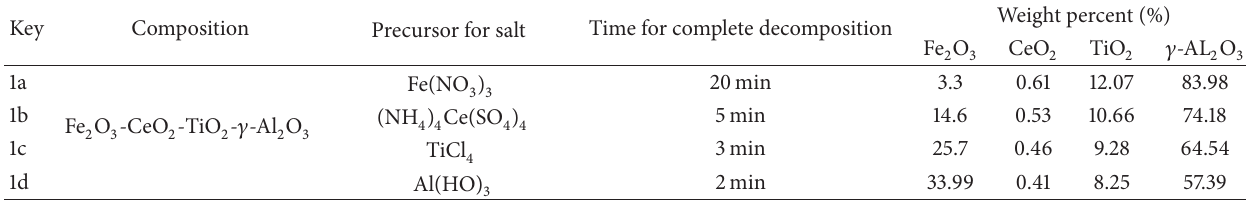
Table 7: Composition of series 1 samples with its catalytic activity.